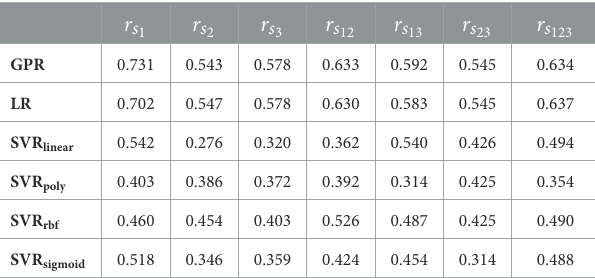
TABLE 3 Criterion validity of modeling with different training data sizes.